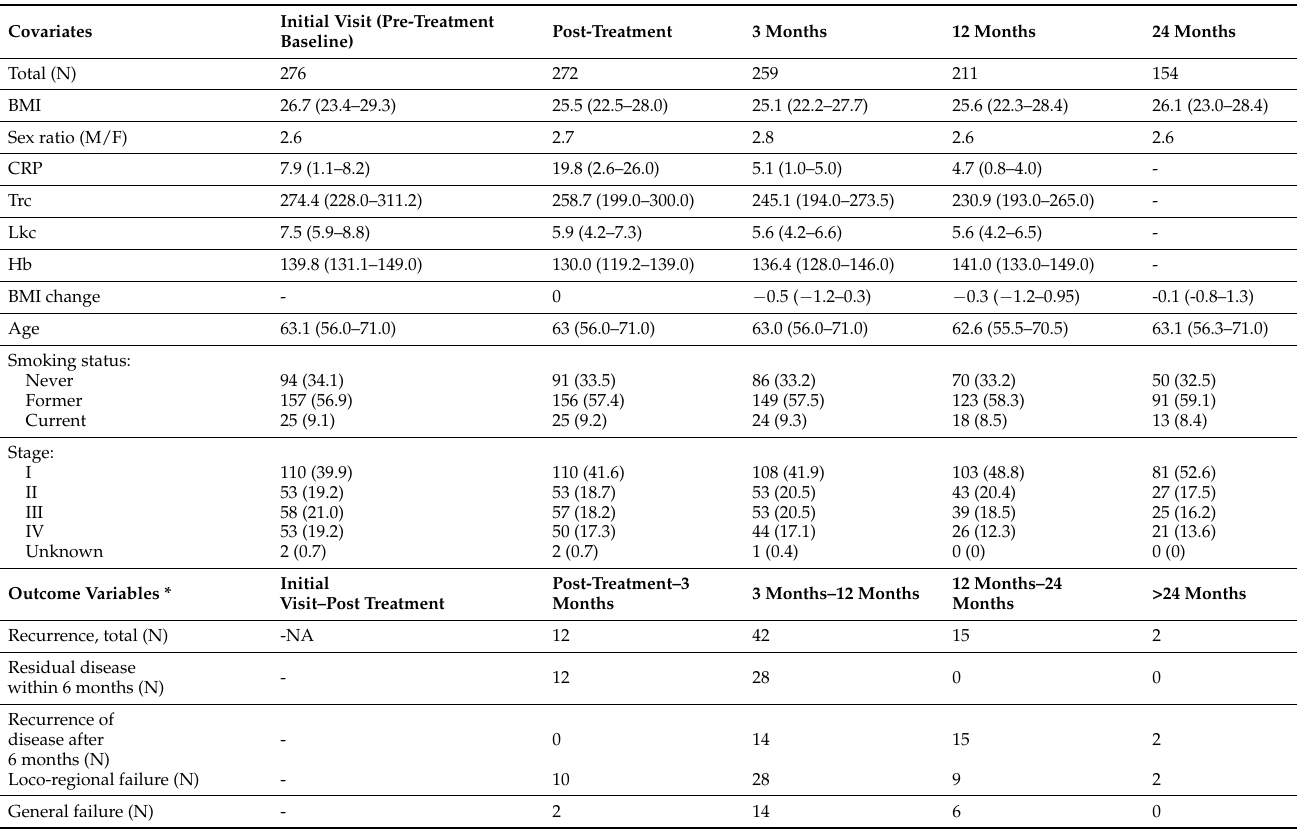
Table 2. Patient descriptives, covariates, and outcomes used in the Cox proportional hazards model. The (x/y) in the table are the 25/75 percentile values or are N (%) for the categorical variables. The model combines the four different